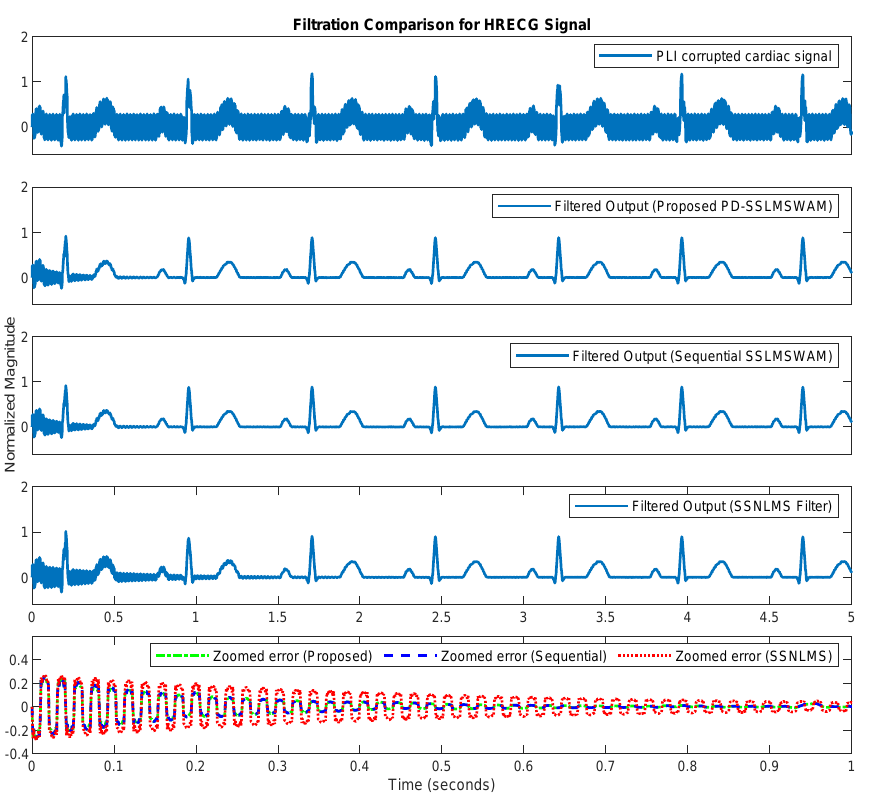
Figure 7. Filtration comparison among the proposed PD–SSLMSWAM, sequentially operated SSLM- SWAM, and SSLNLMS adaptive filters for the HRECG cardiac